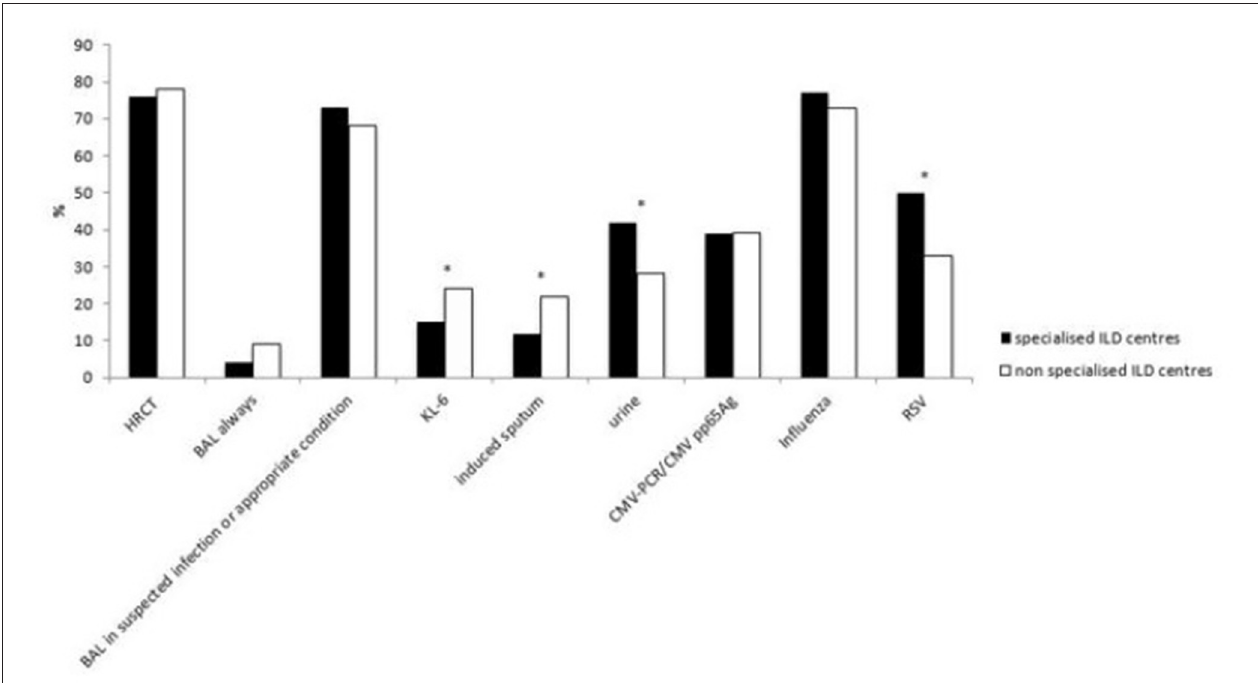
FIGURE 2 | The main diagnostic procedures applied for AE-IPF in specialised and non-specialised ILD centres. Statistically significant differences are labelled with a * (p-value = < 0.05).